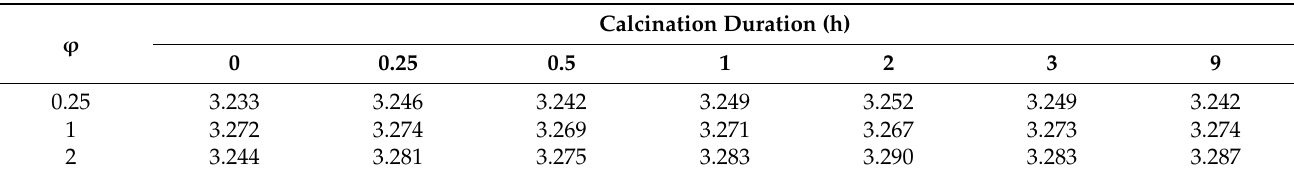
Table 1. The band gap energy (eV) of ZnO at various ϕ and calcination